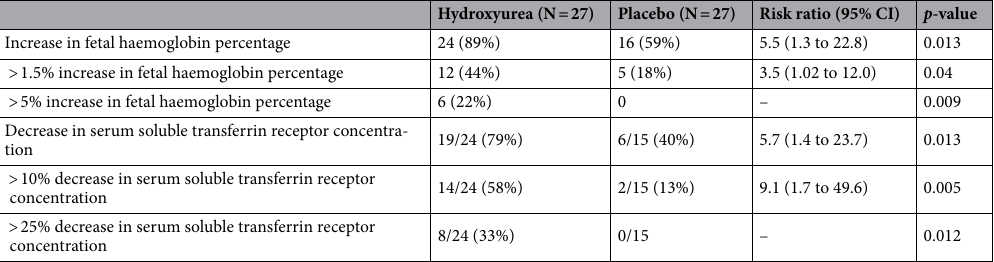
Table 3. Improvements in the secondary outcome measures following treatment. Data are n (%) or n/N (%).